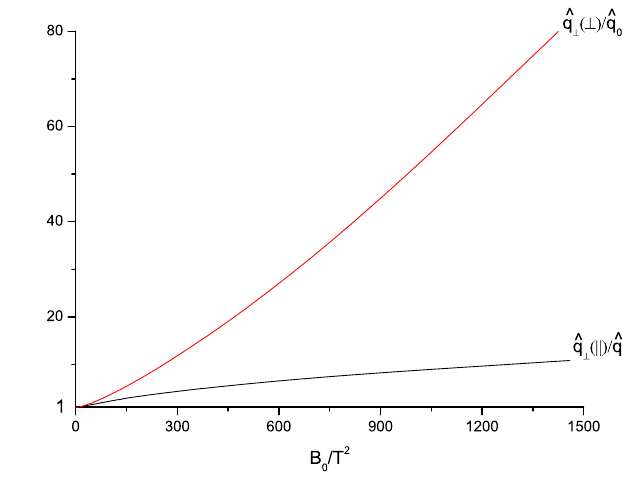
Fig. 3 The plots of ˆ q ⊥ ( (cid:11) ) / ˆ q 0 and ˆ q ⊥ ( ⊥ ) / ˆ q 0 versus B 0 / T